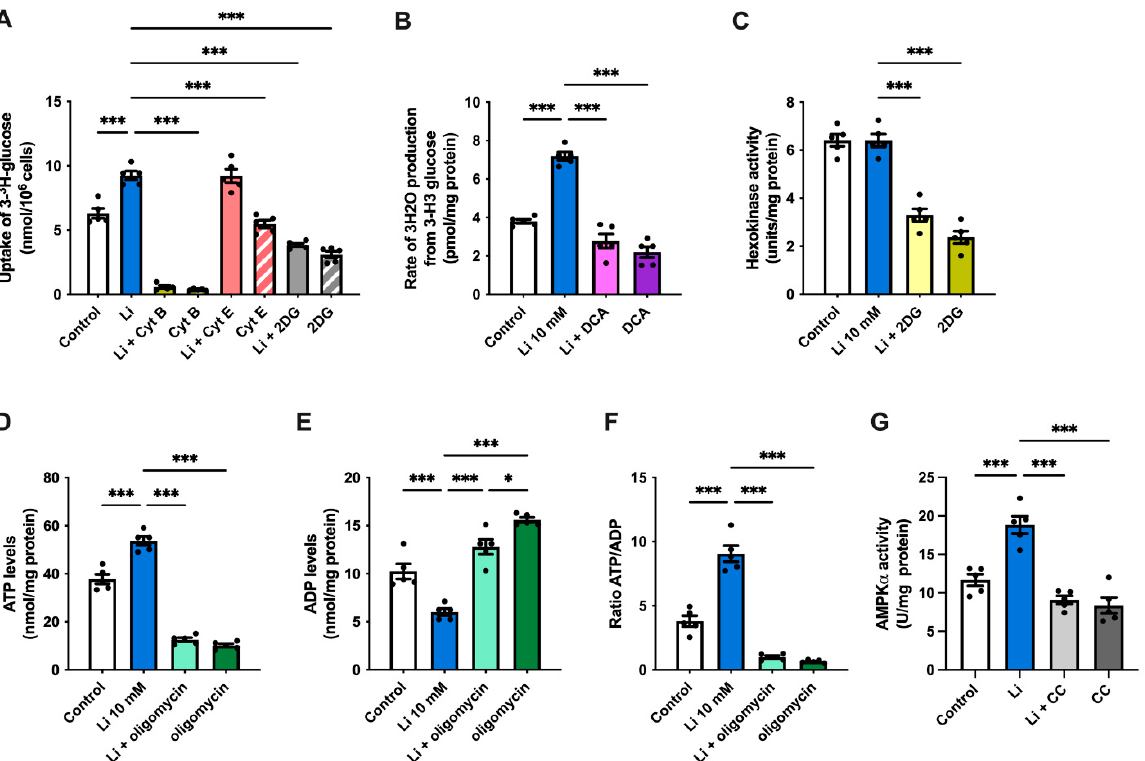
Figure 5. Lithium increases glucose uptake, ATP levels and glycolytic rate in hippocampal slices from APP/PS1 mice ( A ) Effect of 10-mM lithium on 14 C-glucose uptake in hippocampal slices co-treated with either cytochalasin B (Cyt B), cytochalasin E (Cyt E) or 2-deoxy-D-glucose (2DG). ( B ) glycolytic rate of hippocampal slices from APP/PS1 mice treated with 10-mM lithium in the presence or absence of sodium dichloroacetate (DCA) ( C ) Hexokinase activity in APP/PS1 slices treated with 10-mM lithium or 2-deoxy-D-glucose (2DG). ( D – F ) ATP and ADP levels, and ATP:ADP ratio in hippocampal slices treated with 10-mM lithium in the presence or absence of oligomycin. ( G ) AMPK α activity in hippocampal neurons treated with either 10 mM lithium or compound C (CC). Data plotted as means ± SEM (n = 5 independent cell culture preparations). * p < 0.05 and *** p < 0.001 were determined by one-way ANOVA followed by Bonferroni’s post hoc test for multiple comparisons.